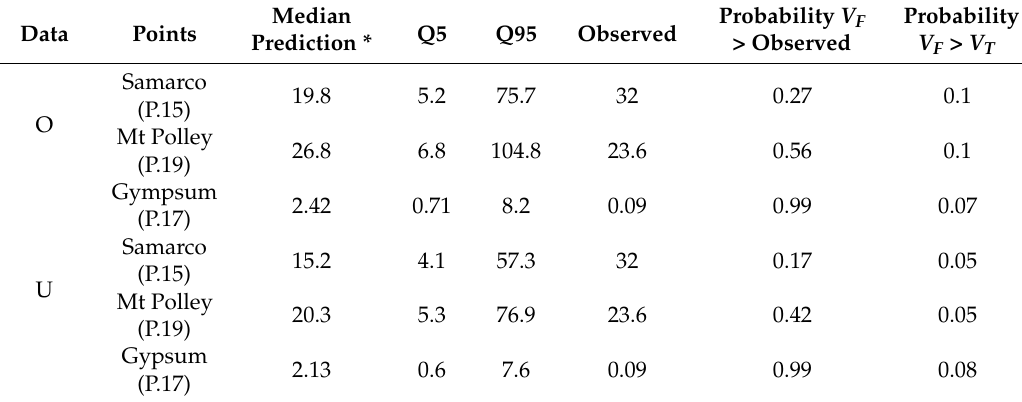
Table 4. Predicted and observed V F values in × 10 6 m 3 for select cases (using all the points in